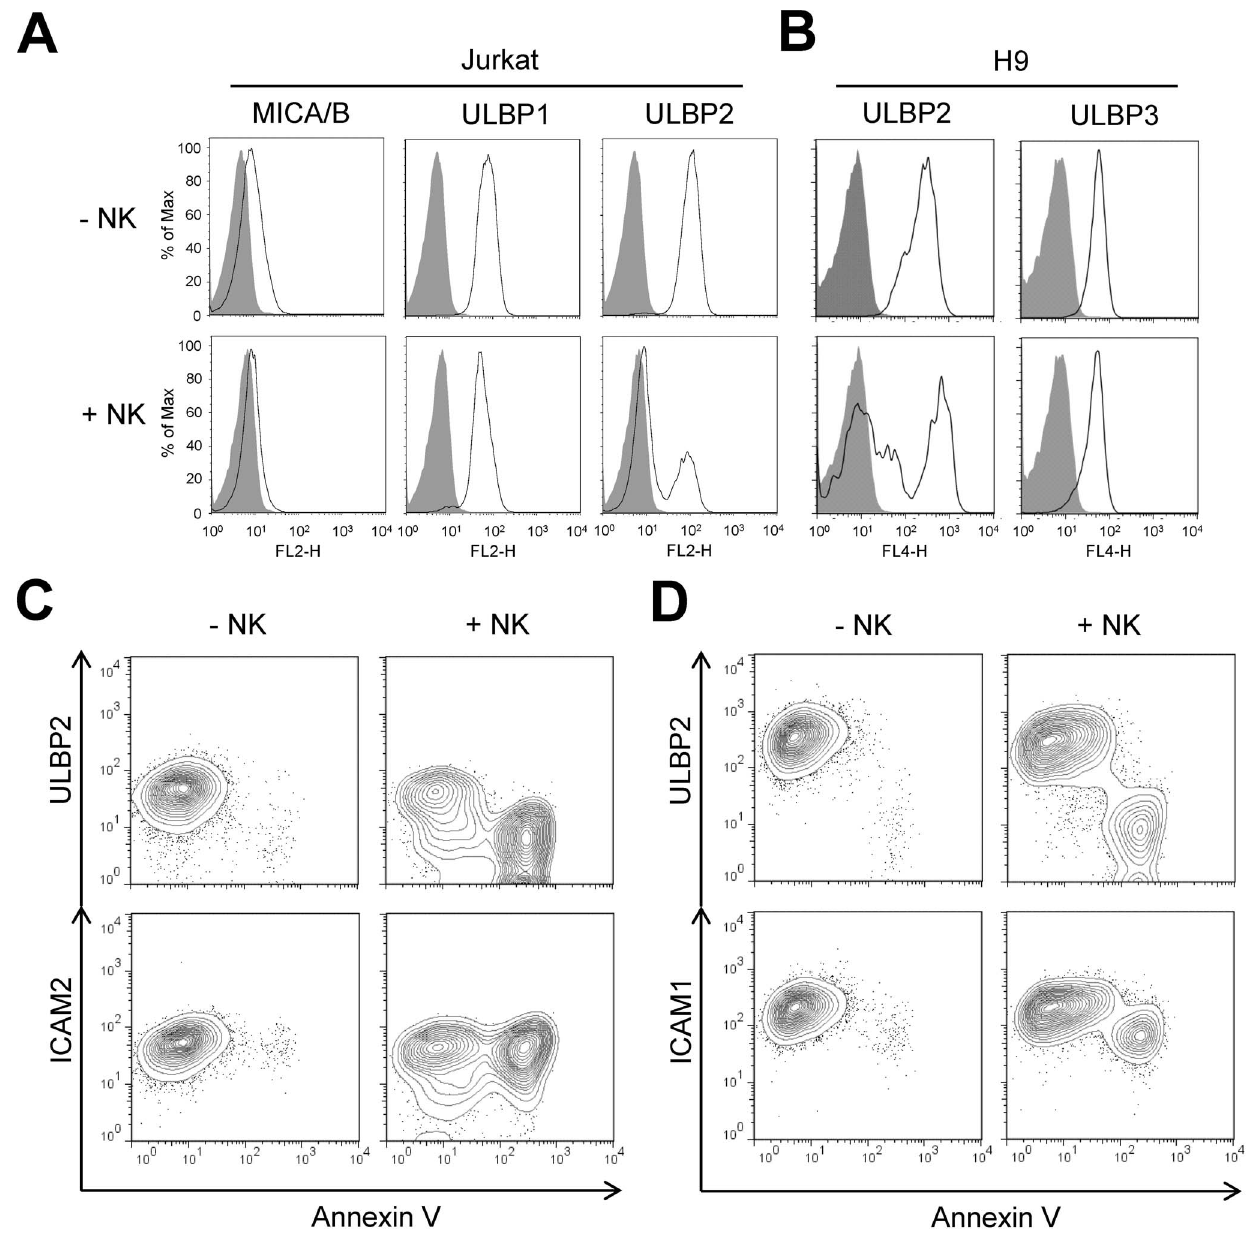
Figure 1. Loss of ULBP2 on target cells during NK cell-mediated cytolysis. (A, B) NK cell-mediated specific down-regulation of ULBP2. 10 5 Jurkat (left panels) or H9 cells (right panels) were incubated with ( + NK) or without ( 2 NK) in an equal number of IL-2 expanded peripheral blood NK cells at 37 u C for 2 hours. The resulting cell mixtures were stained by anti-human MICA/B, ULBP1, ULBP2 or ULBP3 antibodies and analyzed by flow cytometry (solid lines). NK cells were excluded by anti-human CD56 mAb staining. Isotype controls are shown in gray-shaded histograms. (C, D) NK cell-mediated target cell apoptosis leads to loss of ULBP2. 10 5 Jurkat (C) or H9 cells (D) were incubated with ( + NK) or without ( 2 NK) in an equal number of IL-2 expanded peripheral blood NK cells at 37 u C for 2 hours. The resulting cell mixtures were stained by anti-human ULBP2 or ICAM1/2 antibodies, followed by APC-conjugated goat anti-mouse IgG antibody and Annexin V-PE staining, and then analyzed by flow cytometry. NK cells were excluded by FITC conjugated anti-human CD56 mAb staining.